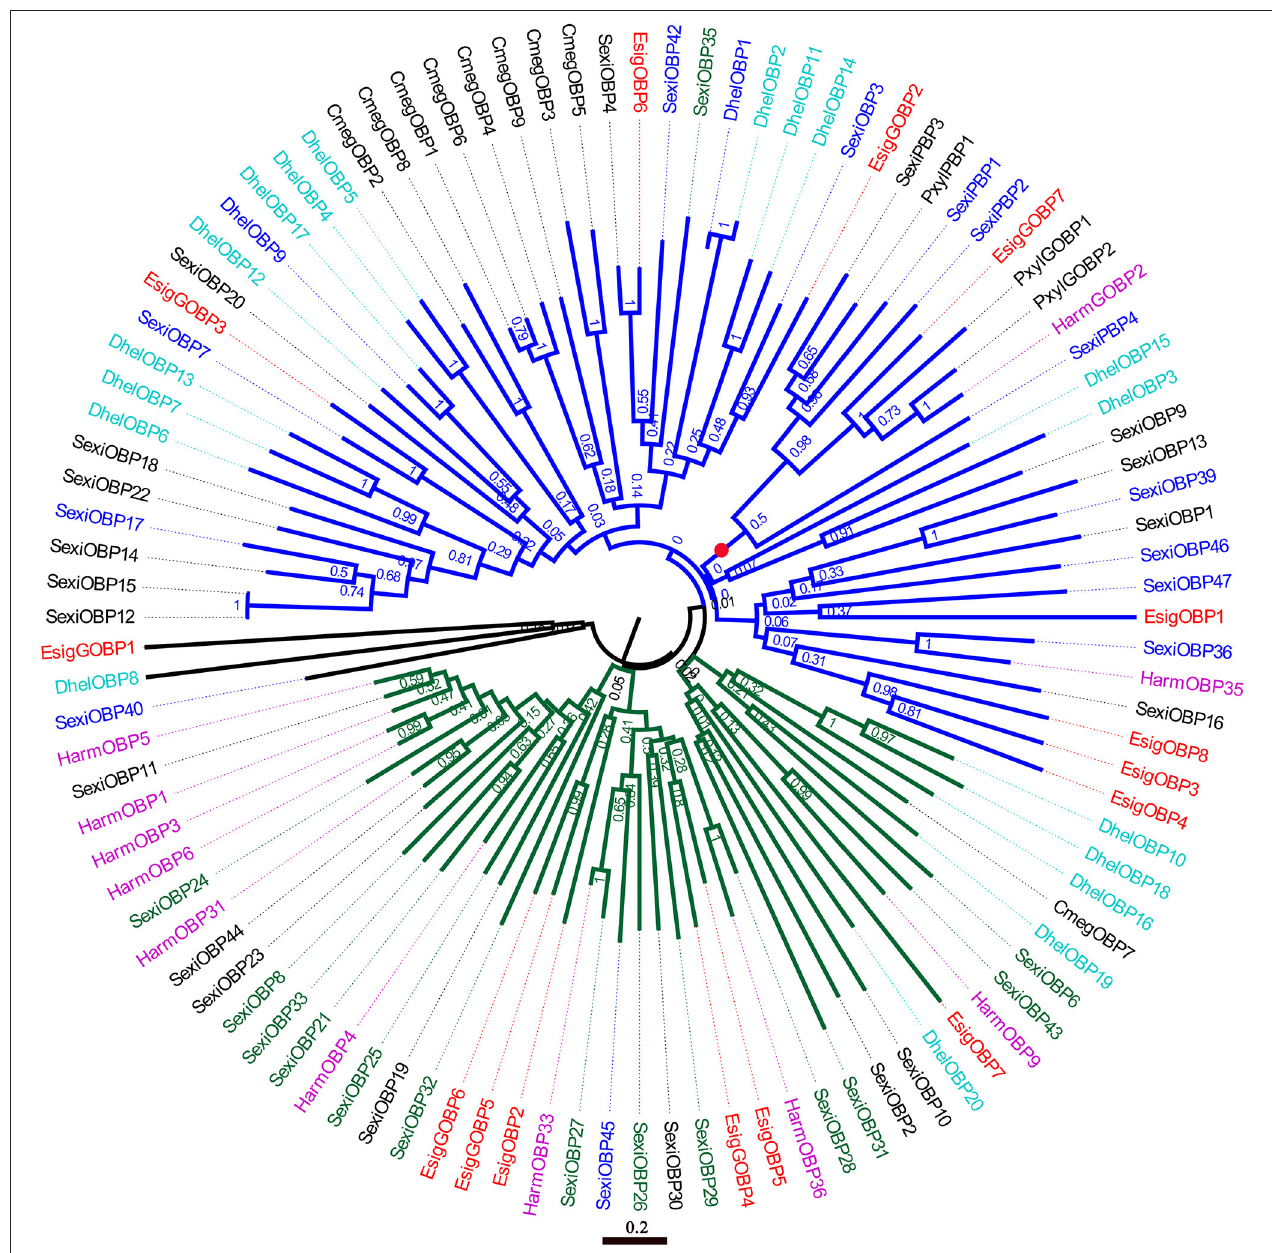
FIGURE 5 | Neighbor-joining phylogenetic tree of odorant-binding proteins (OBPs). The NJ phylogenetic analysis of OBPs of E. signifier (EsigOBP, red) was performed with reference OBPs of D. helophoroides (indigo blue), C. megacephala (black), P. xylostella (black), S. exigua (blue), H. armigera (purple). Green OBPs/GOBPs of P. xylostella showed only larvae expression. The stability of the nodes was assessed by bootstrap analysis with 1,000 replications. The scale bar represents 0.2 substitutions per